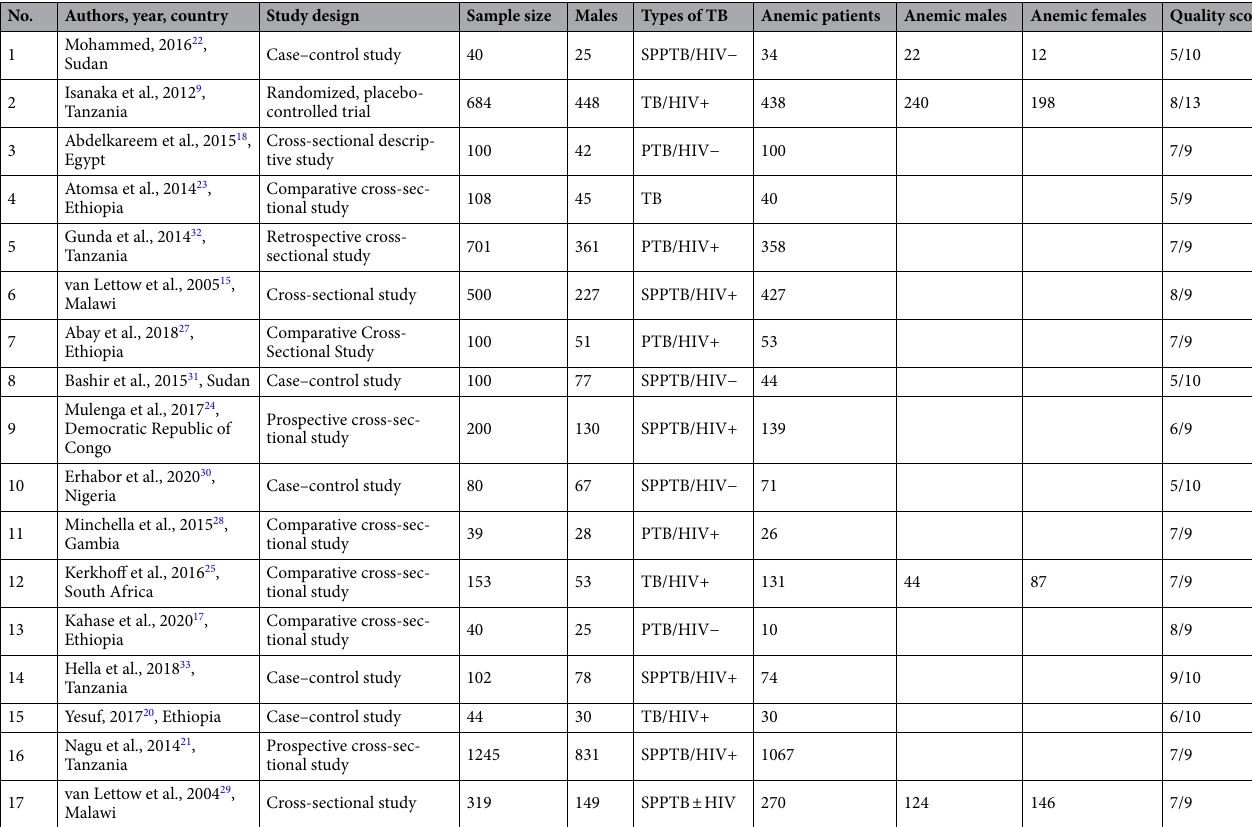
Table 1. A description of studies included in the systematic review and meta-analysis, 2021.